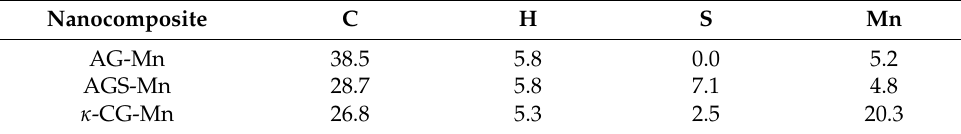
Table 4. Elemental percentages (wt%) of the obtained